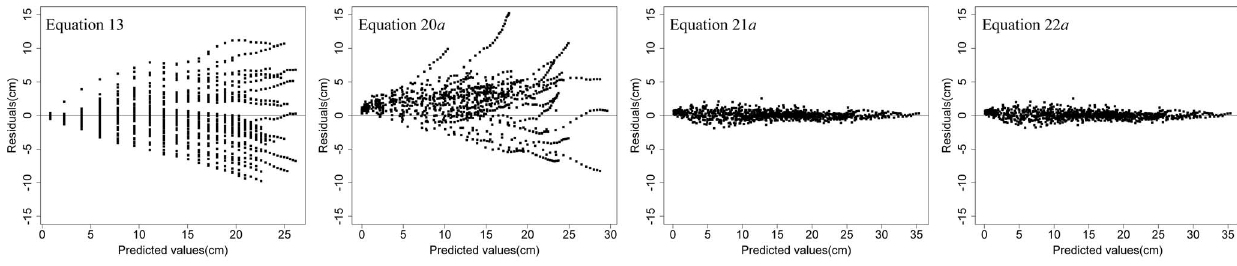
Figure 2. Residual error map of diameter growth of each model.